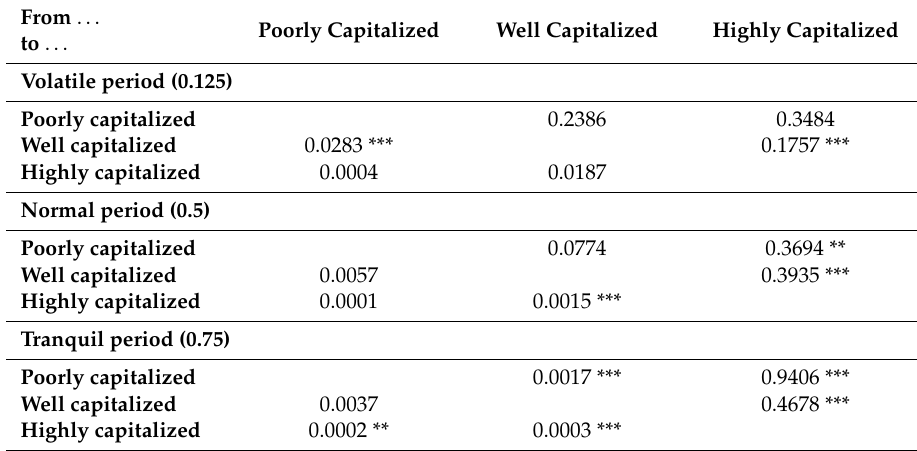
Table 5. Spillover coe ffi cients of the SDSVaR model, based on the market value measure for the size. From ...